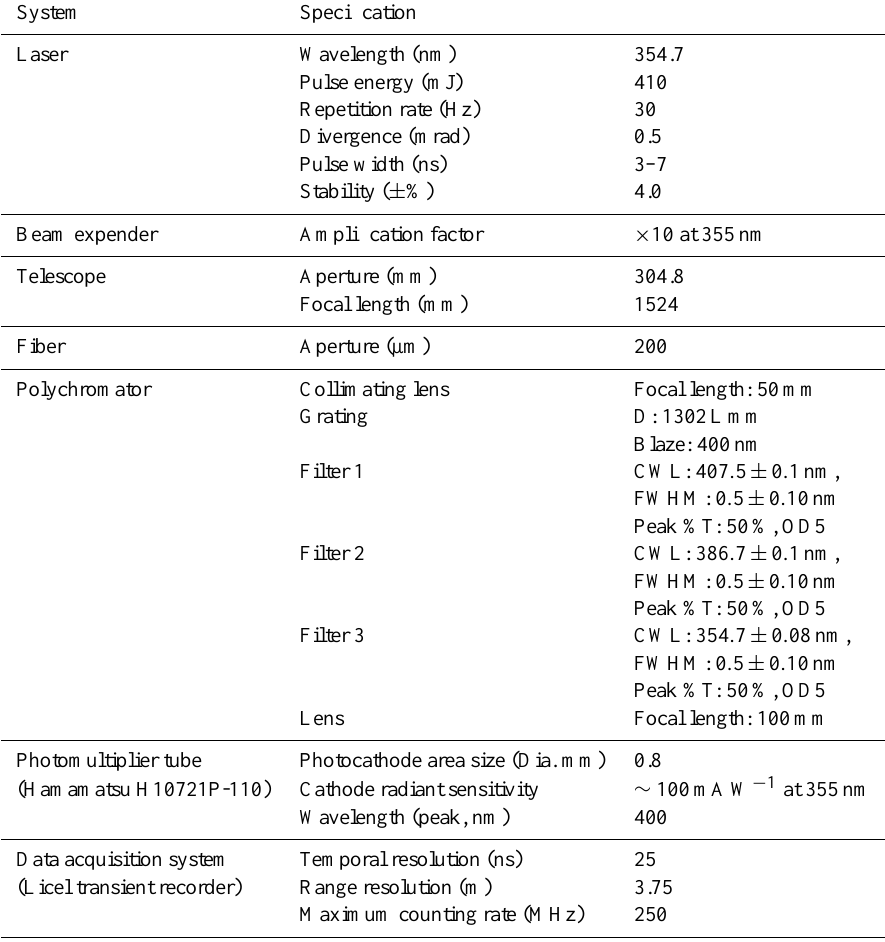
Table 3. System specification of the Raman channel of the WACAL. CWL stands for central wavelength; OD refers to optical